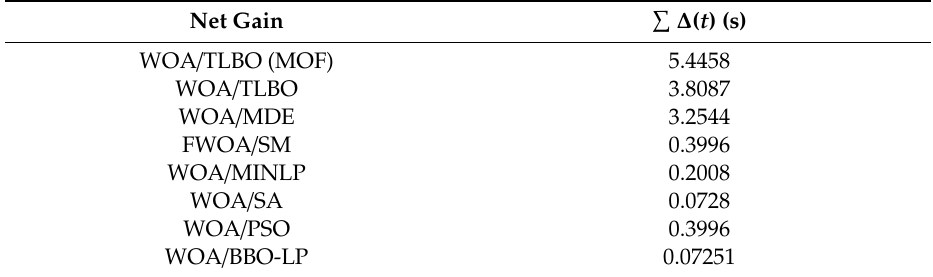
Figure 4. Convergence characteristic of WOA for Case I. Table 4. Comparison of total net gain in time achieved by WOA with the methods used in the literature for IEEE three-bus